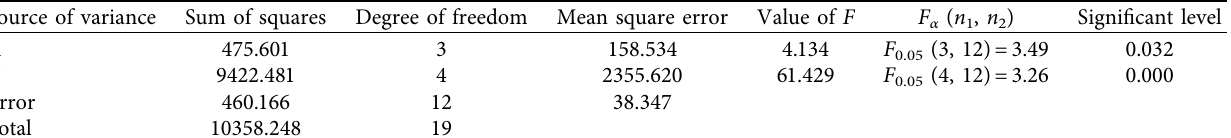
Table 10: ANOVA results of CUTB